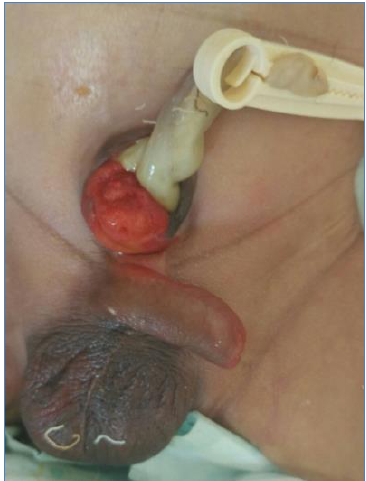
Figure 1: Clinical picture showing bladder mucosa visible on anterior abdominal wall. The patient was prepared for cystourethroscopy and surgery. On cystoscopy, there was a smooth walled good capacity bladder showing both ureteric orifices ectopically placed, very close to the bladder neck. The left orifice was oval and gaping. On surgical exploration, the visible bladder mucosa on the sur- face of the abdominal wall was separate from an intact bladder deep to it. The median umbilical liga- ment was going to the umbilicus which was supe- rior to the duplicate bladder plate. The